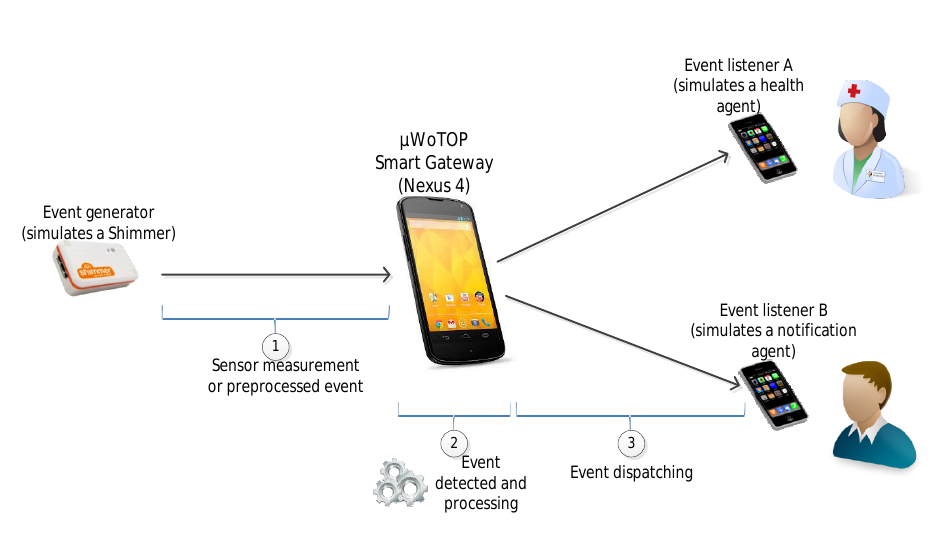
Figure 12. Segments defined to calculate partial delays of the events from the source to the